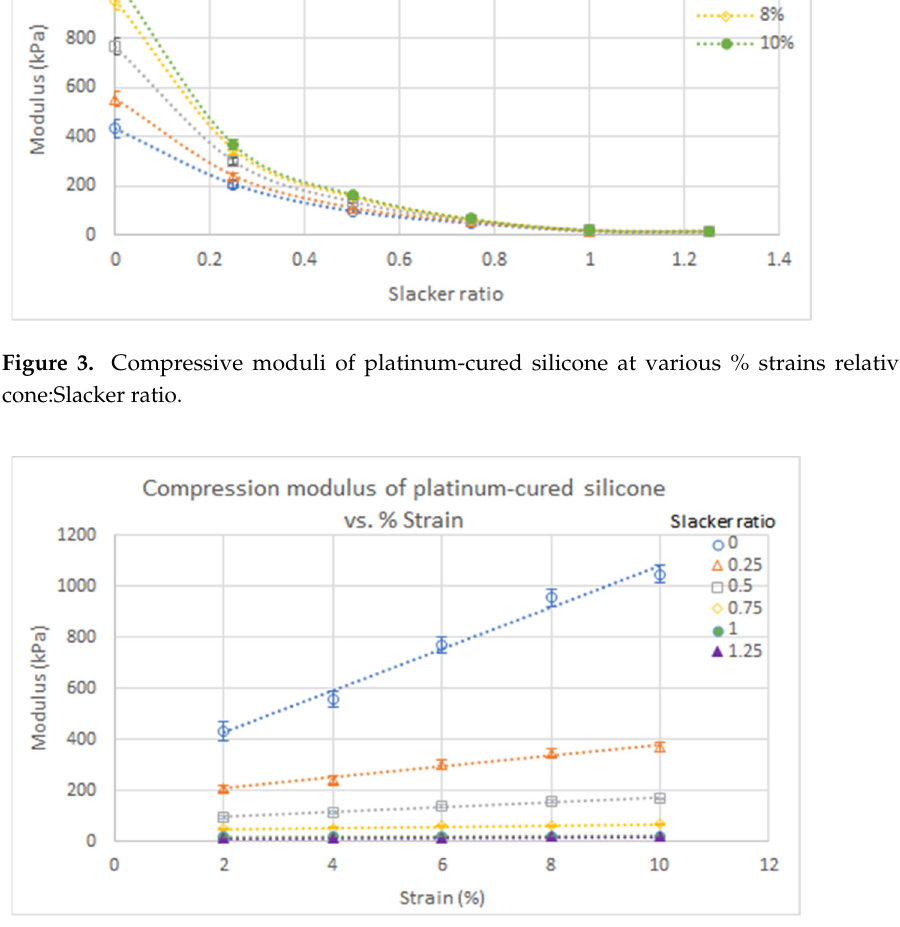
Figure 4. Compressive moduli of platinum-cured silicone at various silicone:Slacker ratios relative to % strain.